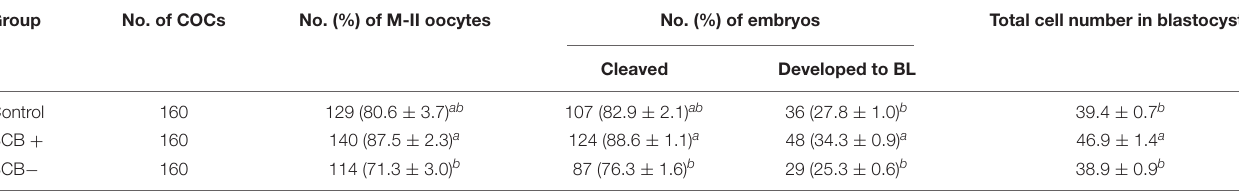
Frontiers in Cell and Developmental Biology |